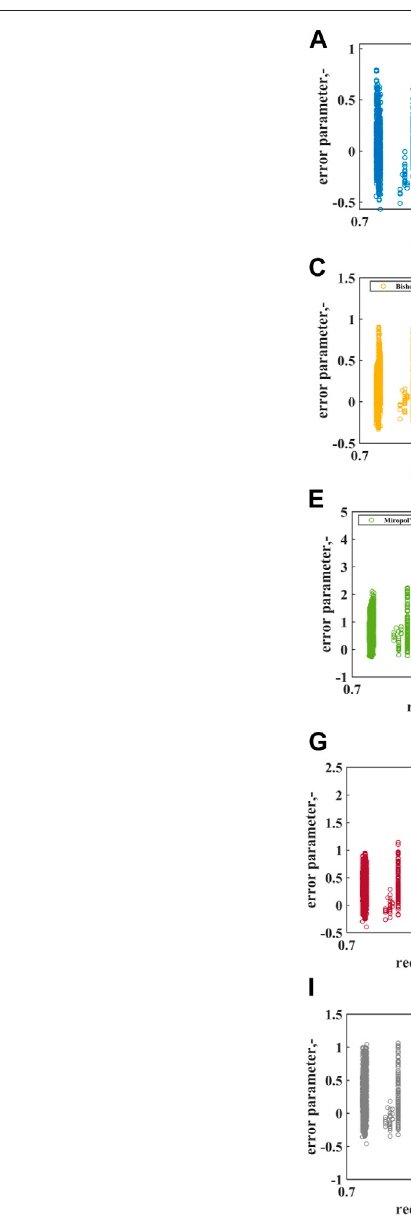
FIGURE 8 | Distribution of error parameters versus reduced pressure for different post-dryout correlation. (A) Song correlation (Song et al., 2021b). (B) Bishop-1 correlation (Bishop et al., 1964). (C) Bishop-2 correlation (Bishop et al., 1964). (D) Bishop-3 correlation (Bishop et al., 1964). (E) Miropol ’ skii correlation (Miropol ’ skii, 1963). (F) Swenson correlation (Swenson et al., 1962). (G) Groeneveld-1 correlation (Groeneveld, 1975). (H) Groeneveld-2 correlation (Groeneveld, 1975). (I) Groeneveld-3 correlation (Groeneveld and Delorme,